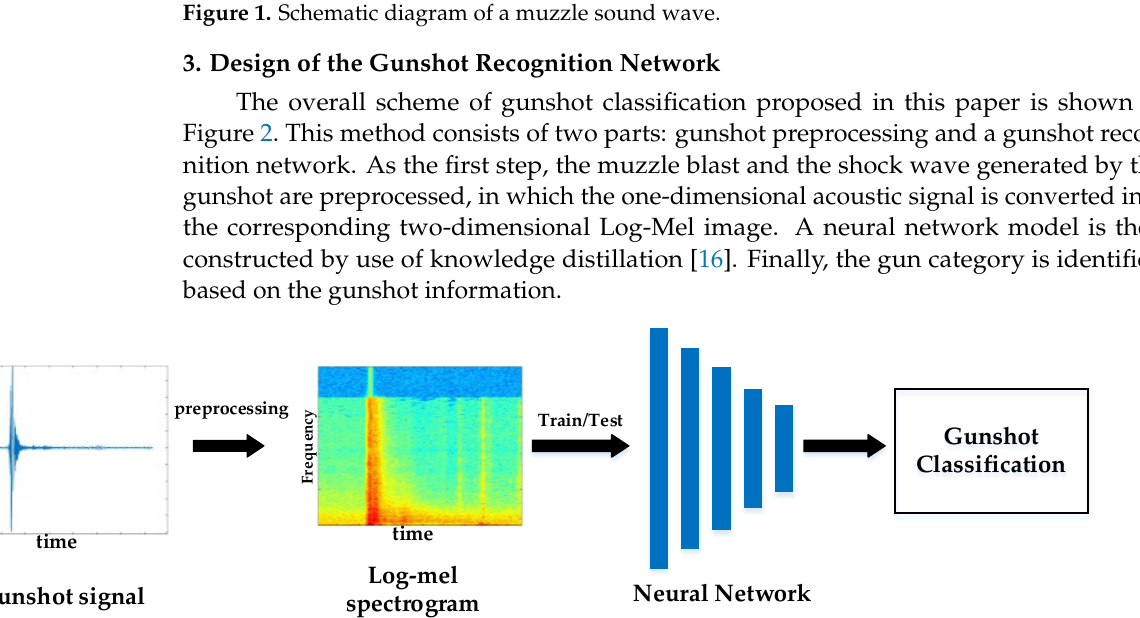
Figure 2. Schematic diagram of the overall scheme of gunshot classification.